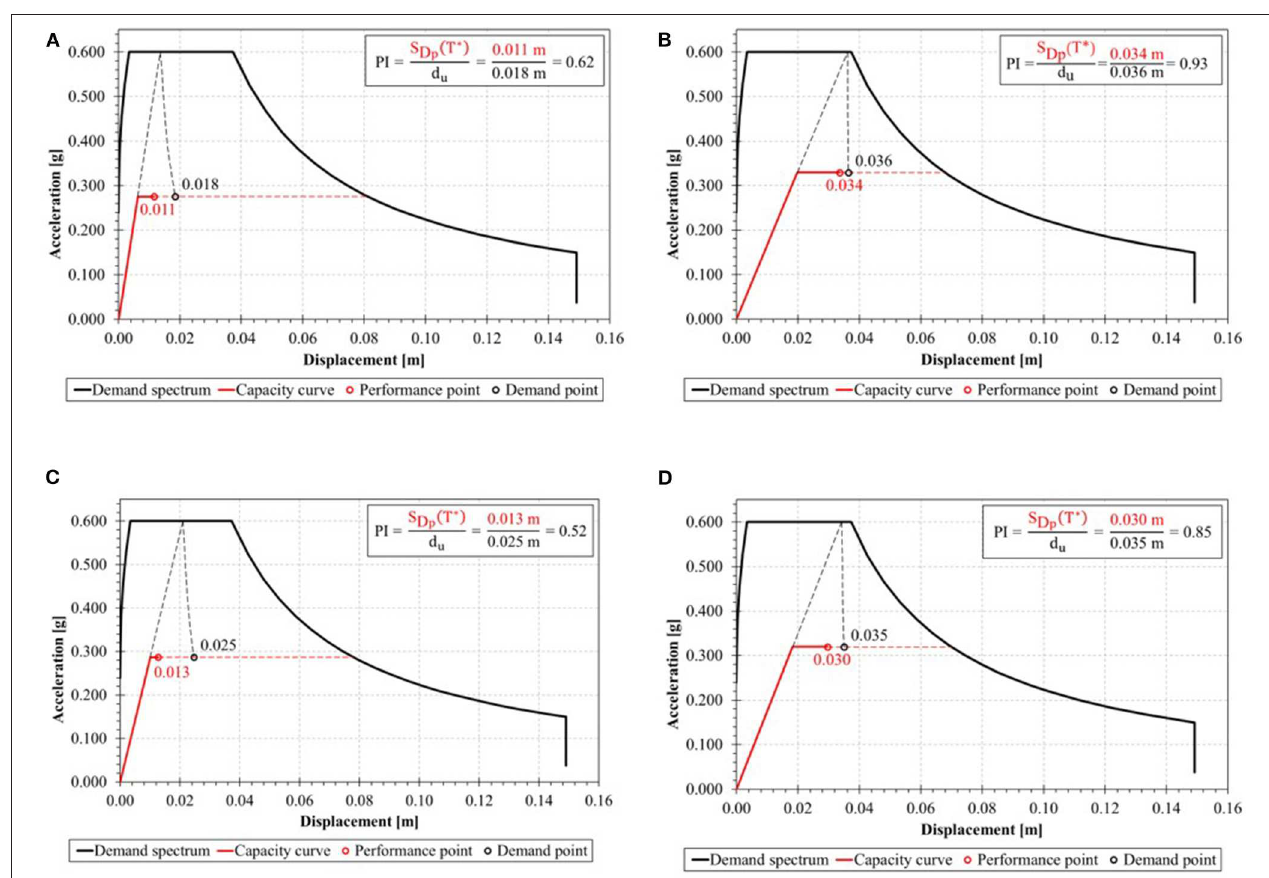
FIGURE 12 | Seismic vulnerability analysis of two different modeling approaches. (A) Verification in the longitudinal direction (X) of the 3D model. (B) Verification in the transversal direction (Y) of the 3D model. (C) Verification in the longitudinal direction (X) of the fiberbeam model. (D) Verification in the transversal direction (Y) of the fiberbeam model.